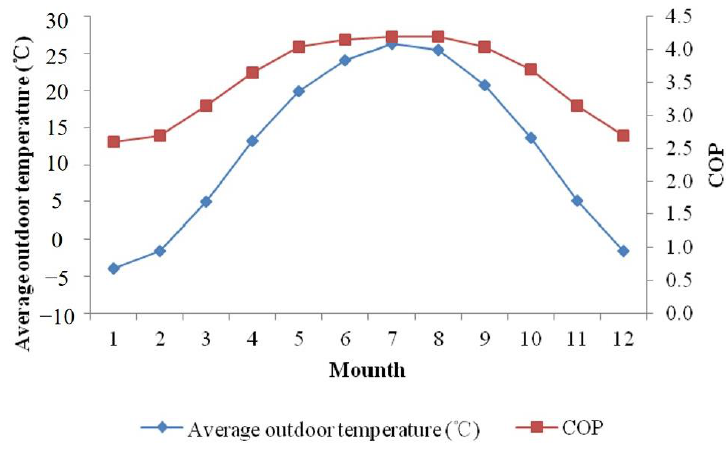
Figure 7. Variations in the average outdoor temperatures and the COP.